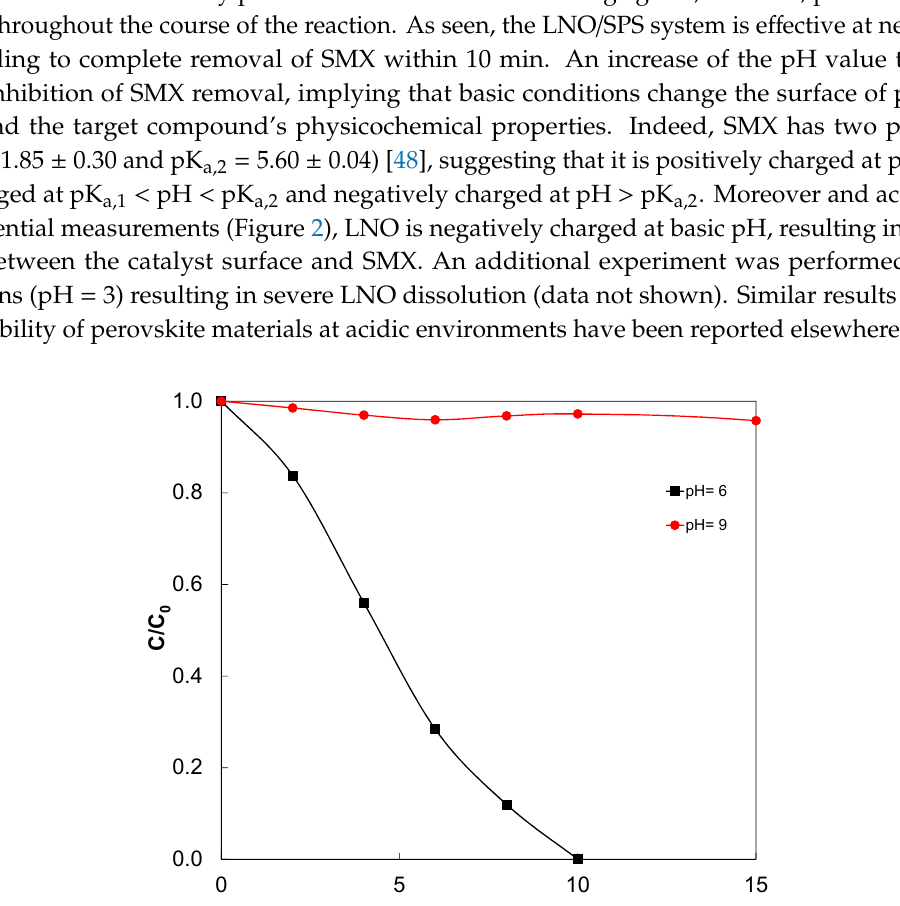
Figure 5. Effect of type of micropollutant on degradation efficiency of methyl paraben (MeP), piroxicam (PIR) and SMX in LNO/SPS system. Experimental conditions: C compound = 500 μ g/L; C LNO = 250 mg/L; C SPS = 100 mg/L; pH = 6; room temperature.